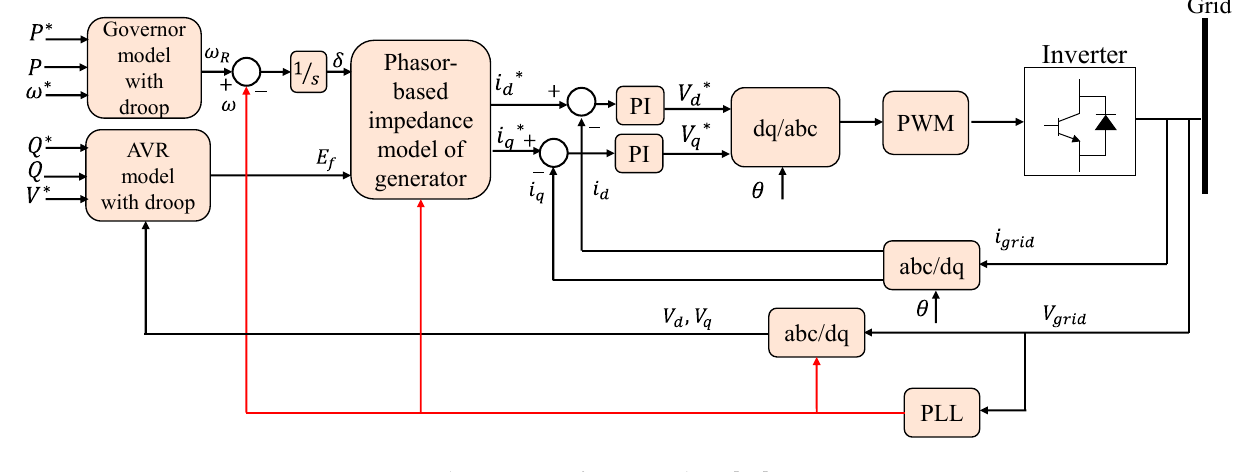
Figure 8. Simple structure of KHI topology [29].